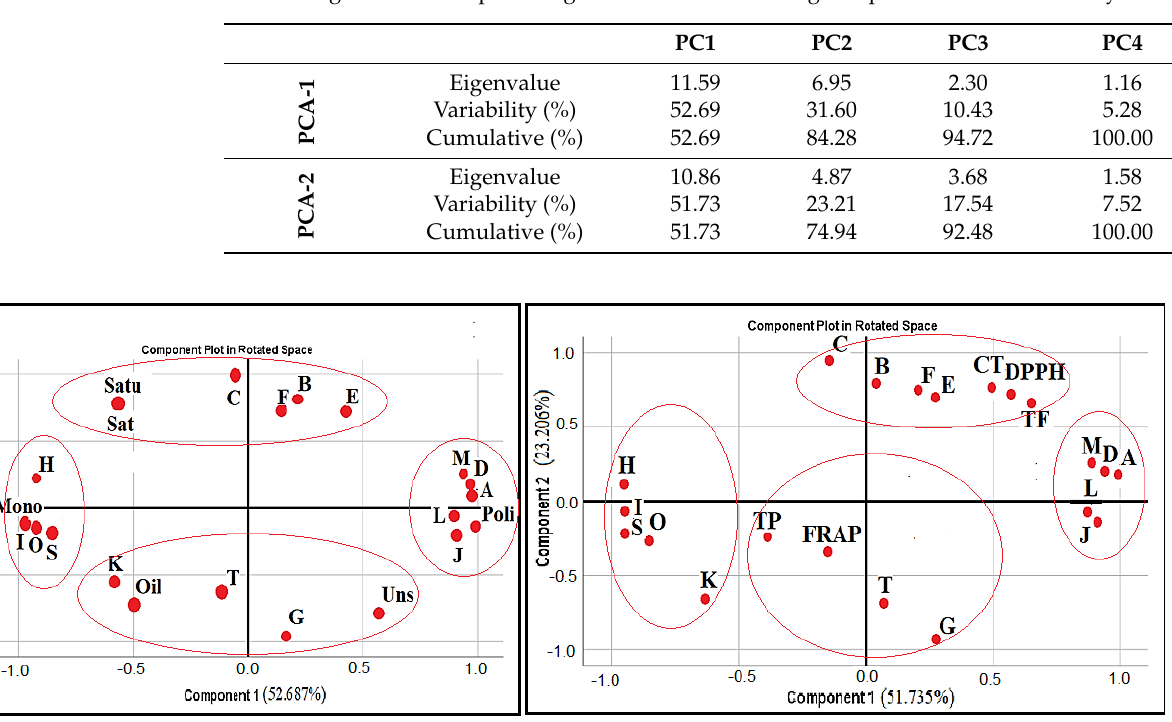
Figure 1. PCA-1 and PCA-2 score plot bases on the fatty acid composition with oil contents and the fatty acids together with antioxidant parameters. Abbreviations and labels: ( A ) Butyric acid methyl ester, ( B ) caproic acid methyl ester, ( C ) undecanoic acid methyl ester, ( D ) lauric acid methyl ester, ( E ) myristic acid methyl ester, ( F ) palmitic acid methyl ester, ( G ) heptadecanoic acid methyl Eeter, ( H ) stearic acid methyl ester, ( I ) oleic acid methyl ester, ( J ) linoleic acid methyl ester, methyl ester, ( S ) cis -58111417 eicosapentaenoic acid methyl ester, ( T ) lignoceric acid methyl ester, ( Sat ) saturated fatty acids, ( Uns ) unsaturated fatty acids, ( Satu ) saturated/unsaturated fatty acid ratio, ( Mono ) monounsaturated fatty acids, ( Poli ) polyunsaturated fatty acids, ( Oil ) oil content, ( TP ) total phenolic content, ( TF ) total flavonoid content, ( CT ) condensed tannin content, ( FRAP ) ferric reducing antioxidant power, ( DPPH ) 1,1-Diphenyl-2-picrylhydrazyl